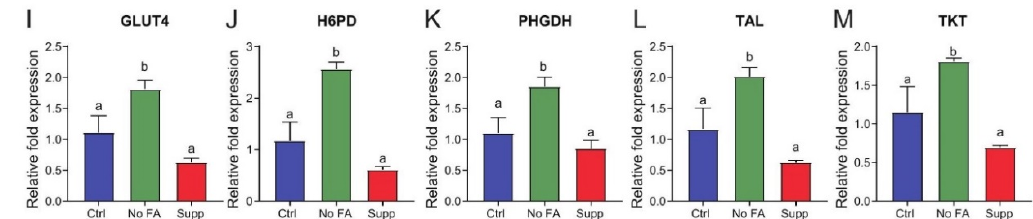
Figure 3. Dietary FA modulates glucose metabolism in MDA-MB-231 tumors. Comparison of glucose-linked metabolites in MDA-MB-231 tumors from control (Ctrl, 2 ppm FA), FA-deficient (No FA, 0 ppm FA), or FA-supplemented (Supp, 12 ppm FA) diets (n = 6 samples/group) ( A – H ). Relative abundance of glucose ( A ), glucose-6-P ( B ), fructose-6-P ( C ), 6-phosphogluconate ( D ), sedohepulose ( E ), sedohepulose-7-P ( F ), UDP-glucose ( G ), UDP-glucuronate ( H ). Expression of GLUT4